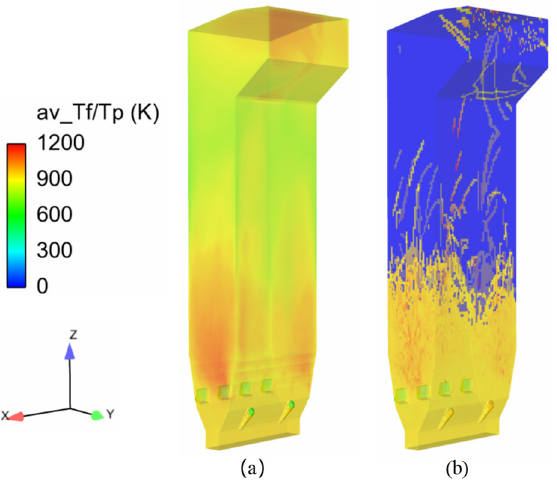
Figure 6. Temperature differences between the particles and gas phase (( a )—gas phase; ( b )—particles).